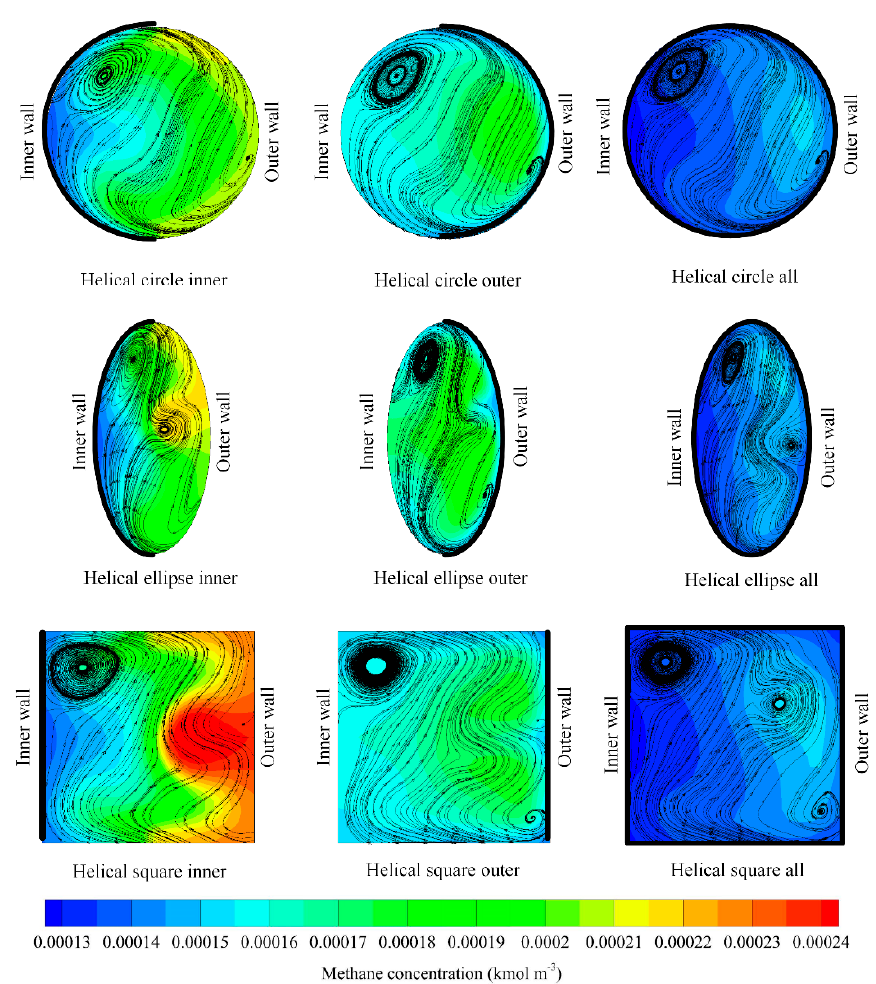
Figure 9. Methane concentration (kmol m − 3 ) and masslines in the helical reactors with various cross-sections and coating strategies at L = 31 cm and Reynolds number of 1000. The coated walls are highlighted in black line.